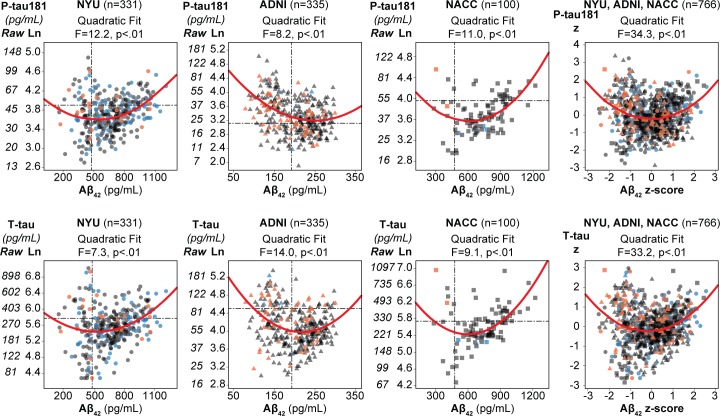
Relationship between Aβ42 and tau in 3 cohorts.Scatter plots for each cohort with Aβ42 on the x-axis and Tau with the natural log transformation (and the associated raw values) on the y-axis. Individual subjects are shown as circles for NYU, triangles for ADNI and squares for NACC. The outcome groups are indicated by color with the cross-sectional NL in blue, Stable NC in gray, and Future MCI/AD in orange. The quadratic fit is shown as a solid red line. The F statistic is from additive value of the quadratic fit to the model including the linear fit and standard confounds. Published cut offs for each biomarker [19,21] are depicted with dashed lines. The cohorts were combined after Z scoring.